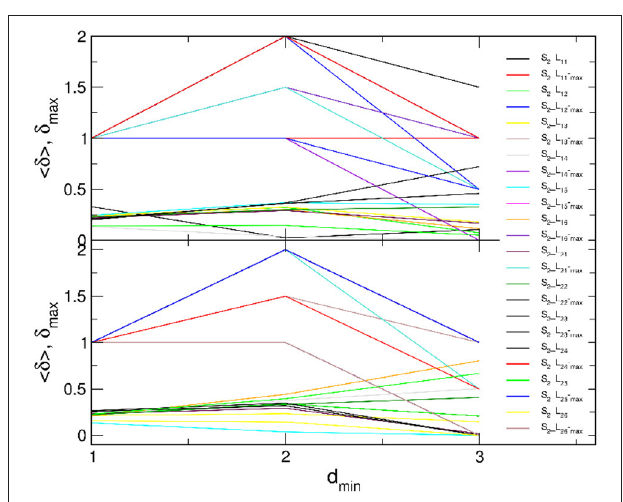
FIGURE 5 | Curvature plots of B2BCN of all speaker-listener pairs: (Top) all listeners with speaker S 1 and (Bottom) all listeners with speaker S 2 (legend). In each panel, lower curves refer to the average hyperbolicity h δ i and upper curves to δ max found in the entire network, plotted against d min .